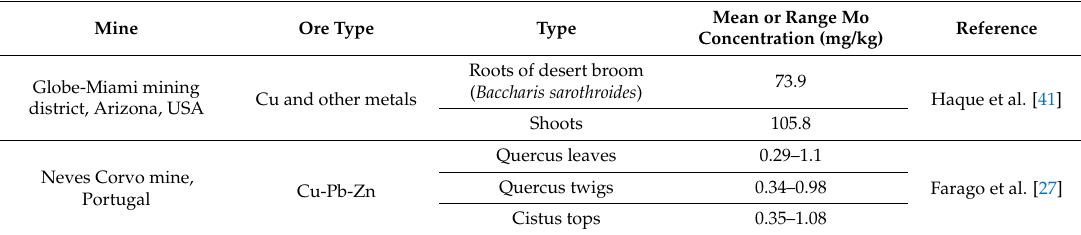
Table 4. Concentrations of Mo in mining-affected